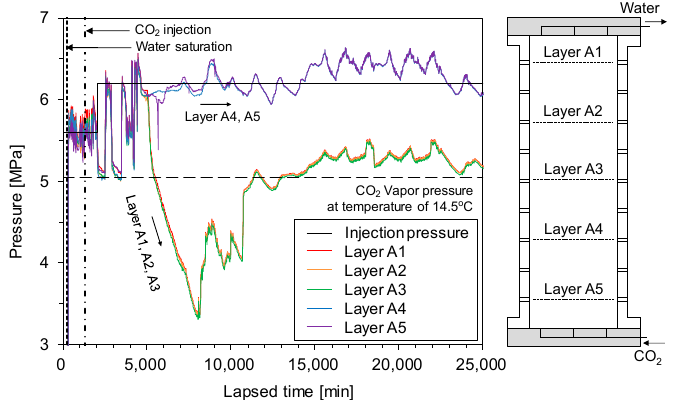
Figure 4. Pressure of the cell with lapsed time during CO 2 injection.